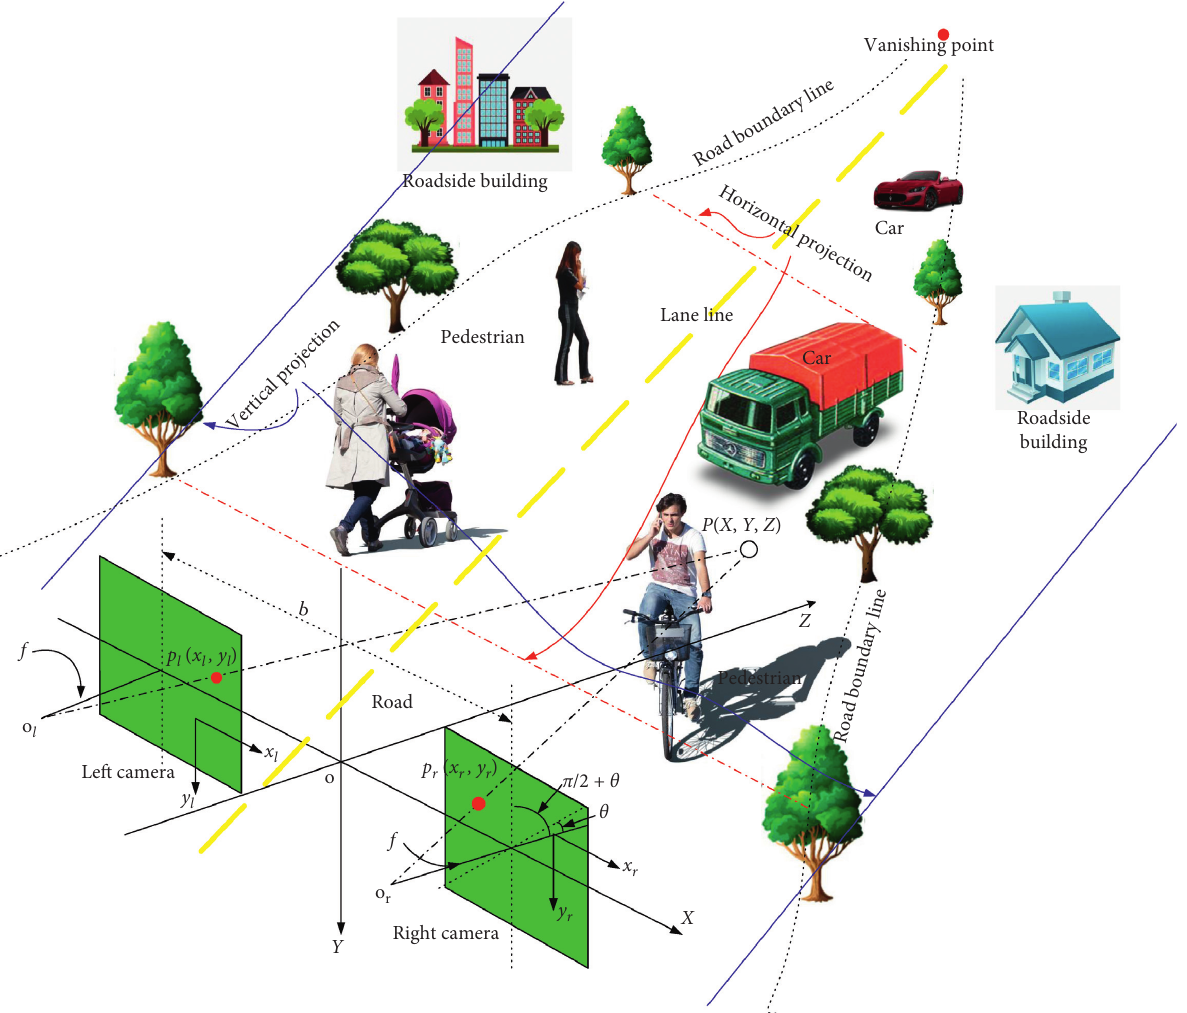
Figure 1: Stereo vision road scene model.